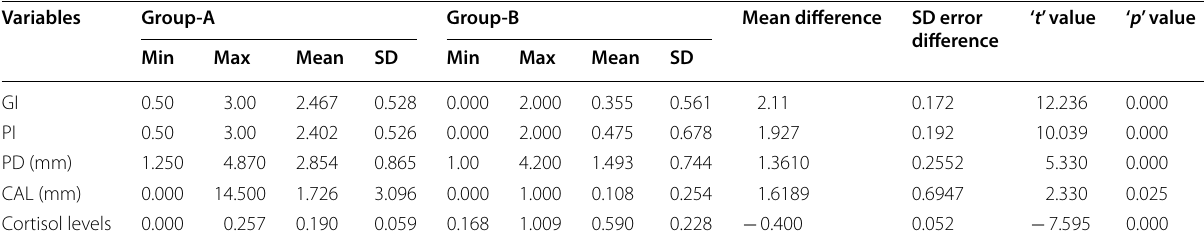
Table 2 Comparison of clinical periodontal parameters and salivary cortisol levels between two groups Variables